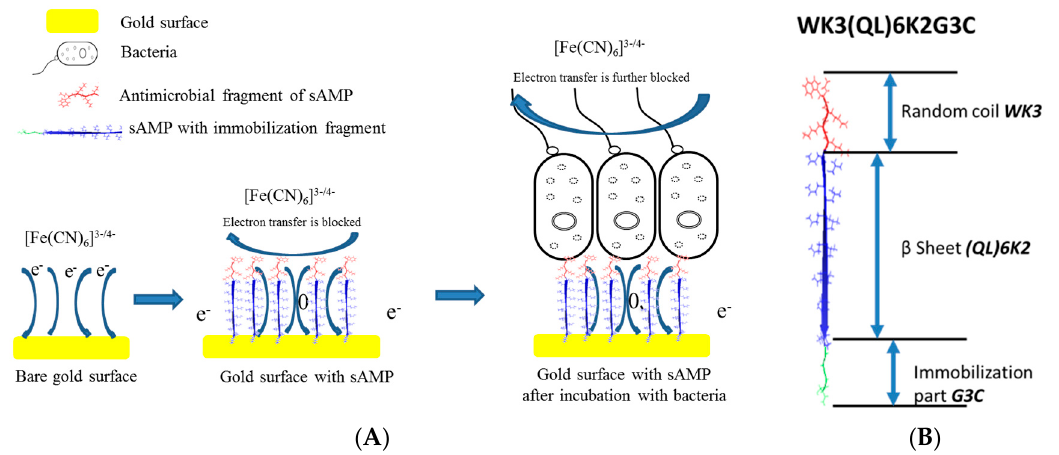
Figure 15. ( A ) Impedimetric bacteria sensing platform using synthetic cysteine-modified AMP. ( B ) Sequence and orientation of the active peptide (WK 3 (QL) 6 K 2 G 3 C) on AuNPs functionalized electrode (adapted with permission from [56]).